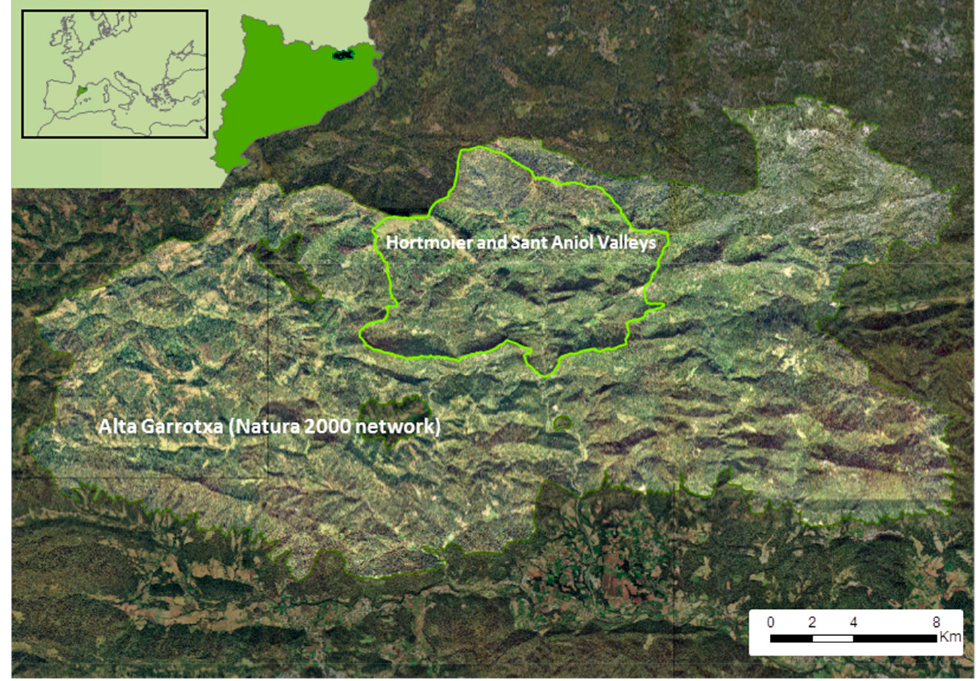
Figure 1. Location of the study area.